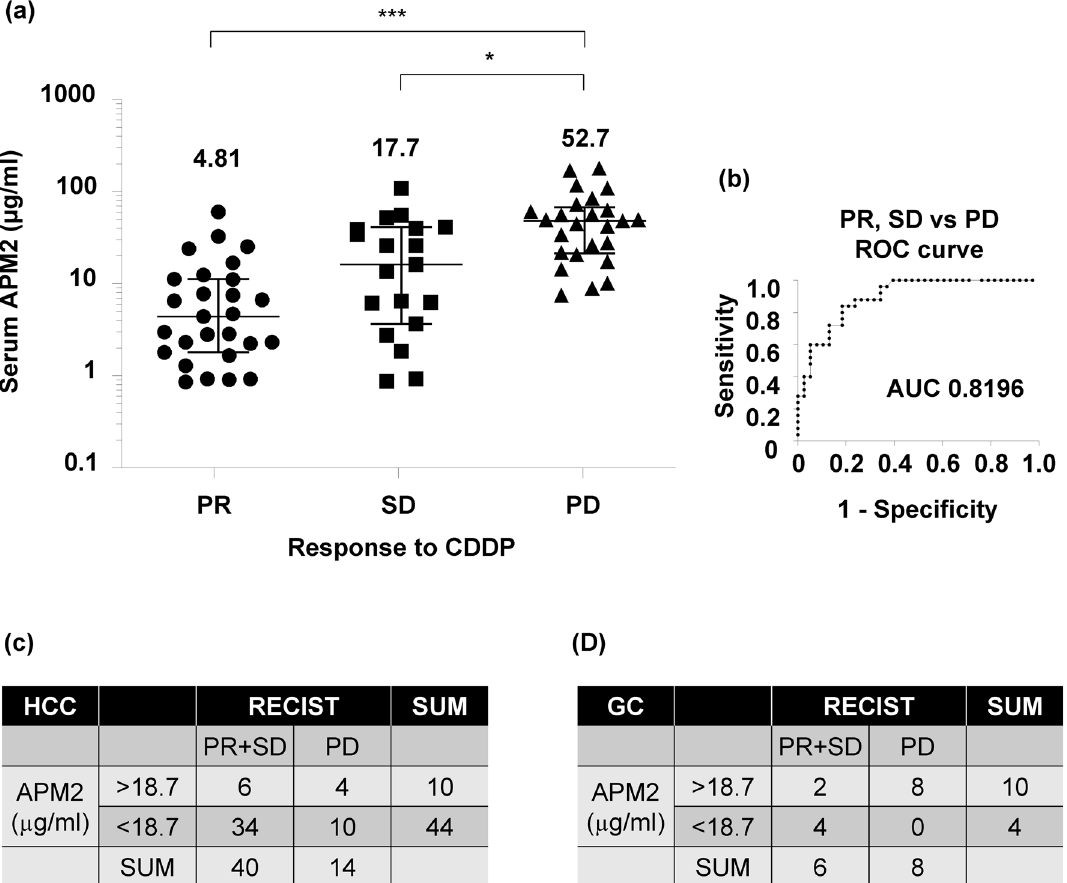
Figure 6. Serum concentration of APM2 and chemosensitivity to CDDP in the Patients with HCC or GC. ( a ) enzyme-linked immunosorbent assay (ELISA) was performed on serum collected from 71 patients described before administration of cisplatin (CDDP). Partial response (PR), n = 27; stable disease (SD), n = 19; and progressive disease (PD), n = 25. The values represent mean ± standard deviations. * p < 0.05, *** p < 0.001, One- way analysis of variance followed by Bonferroni’s multiple comparison test. ( b ) Receiver operating characteristic (ROC) curves are used to determine a cut-off value for “PR & SD” vs “PD”. ( c ) A prediction of CDDP chemosensitivity for HCC based on the cut-off value of 18.7 µg/mL. ( d ) A prediction of CDDP chemosensitivity for gastric cancer based on the cut-off value of 18.7 µg/mL. The anti-tumor responses were determined after the first evaluation based on the RECIST or endoscopic findings. APM2 adipose most abundant 2, RECIST response evaluation criteria in solid tumors; GC gastric